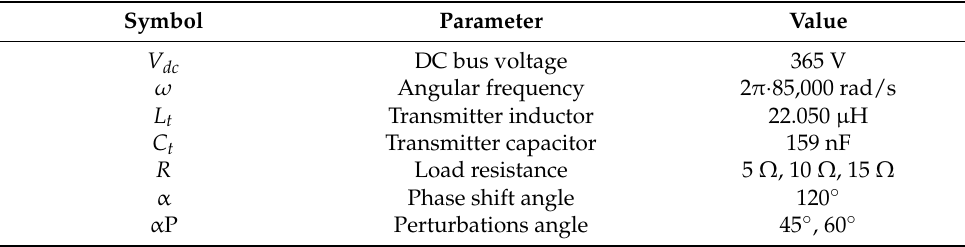
Table 1. Parameters of the Assembled Resonant